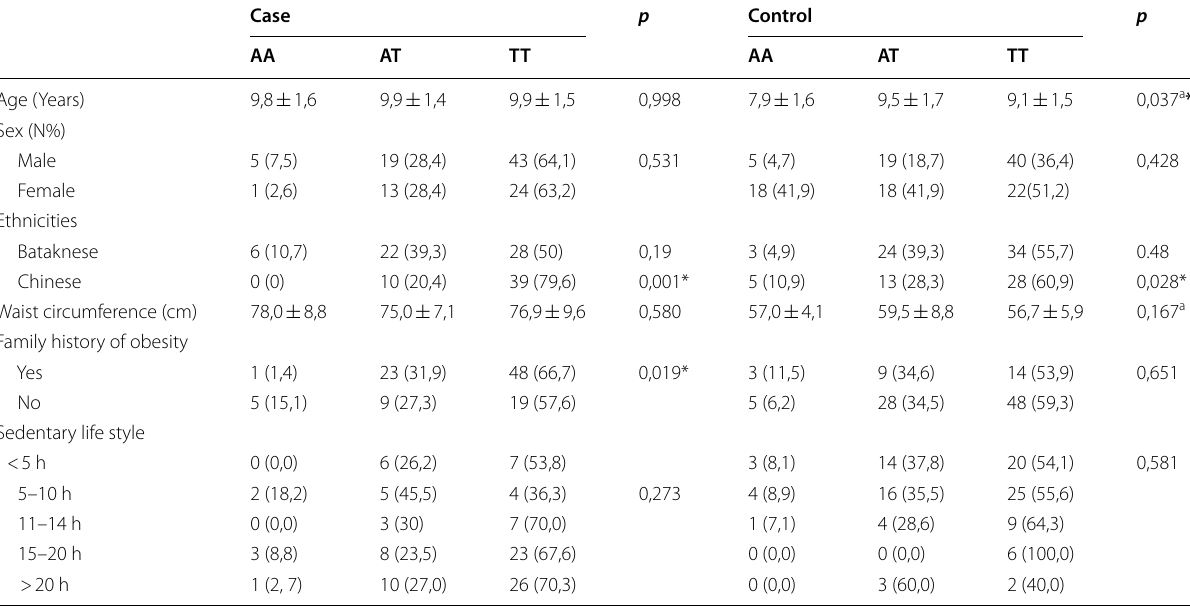
a One way Anova test *Represents significance at p < 0.05